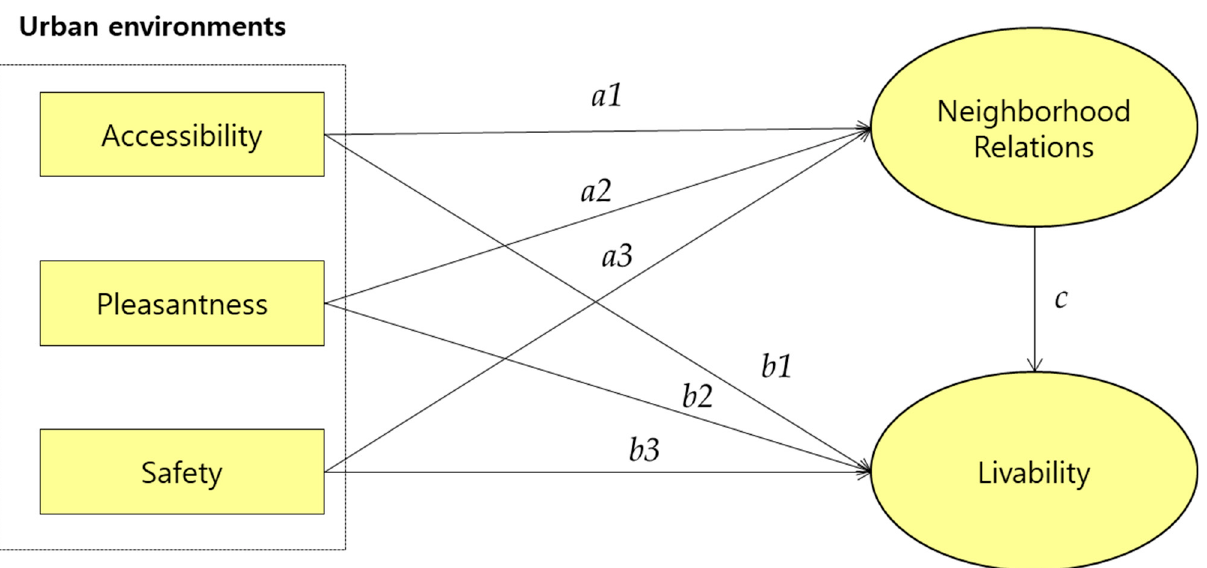
Table 2. Exploratory factor analysis (EFA) and reliability analysis.